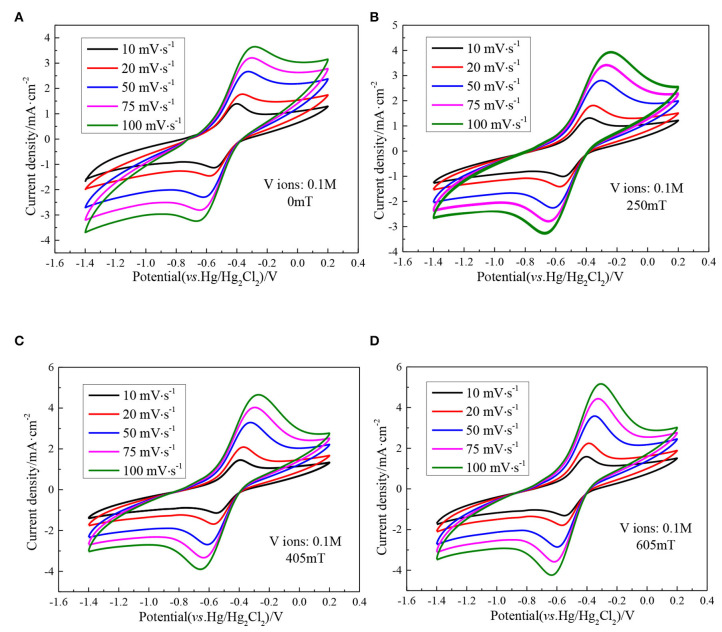
CV curves of 0.1 M VCl3 with different magnetic field intensities at different scan rates, (A) 0 mT; (B) 250 mT; (C) 405 mT; (D) 605 mT.